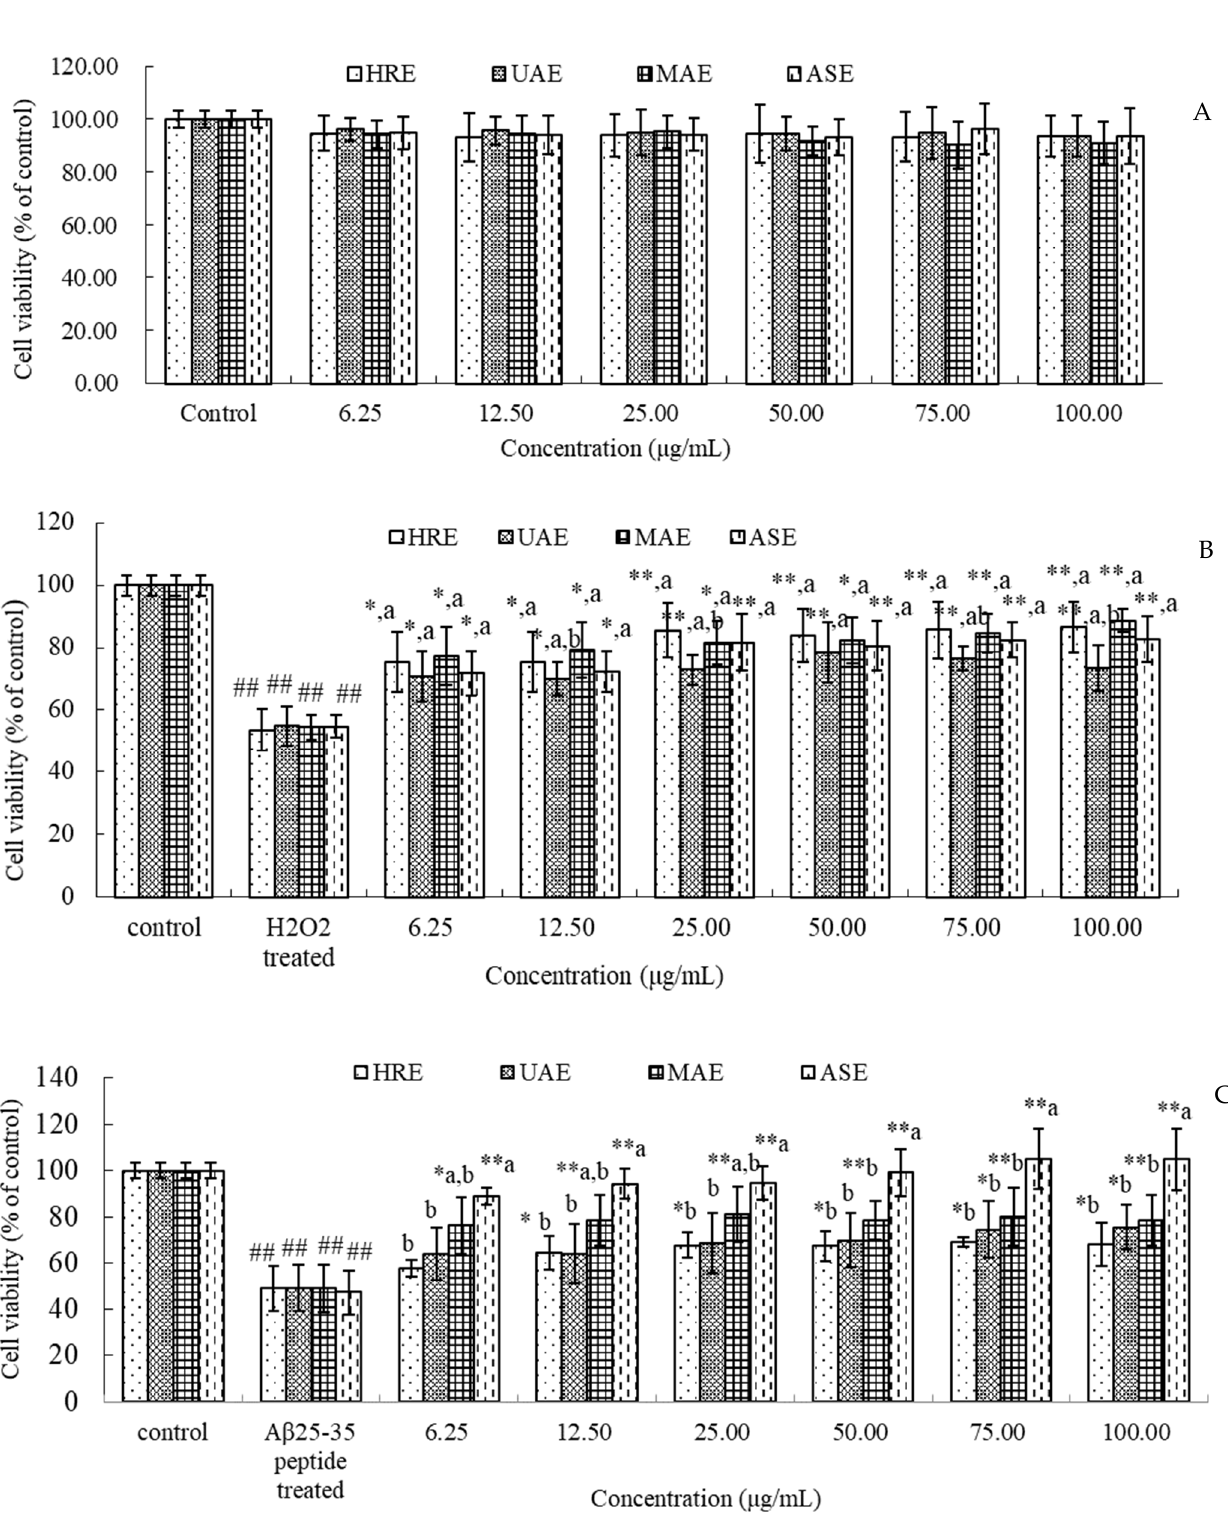
Figure 3. Effects of Gardeniae fructus extracts on the cell viability of PC12 cells in ( A ) basic condition, ( B ) H 2 O 2 -induced, or ( C ) A β 25–35 -induced toxicity. PC12 cells were pre-incubated with extracts (6.25–100 µ g/mL) for 2 h prior to treatment with 100 µ mol/L of H 2 O 2 or 20 µ mol/L of A β 25–35 peptide for 24 h. After the treatment, cell viability was determined by MTT analysis (n = 4). Data were shown as means ± SD. ## p < 0.01 compared to control, * p < 0.05, ** p < 0.01 compared to H 2 O 2 - or A β 25–35 peptide-treated groups. a,b mean significant difference between four different extract methods ( p < 0.05).